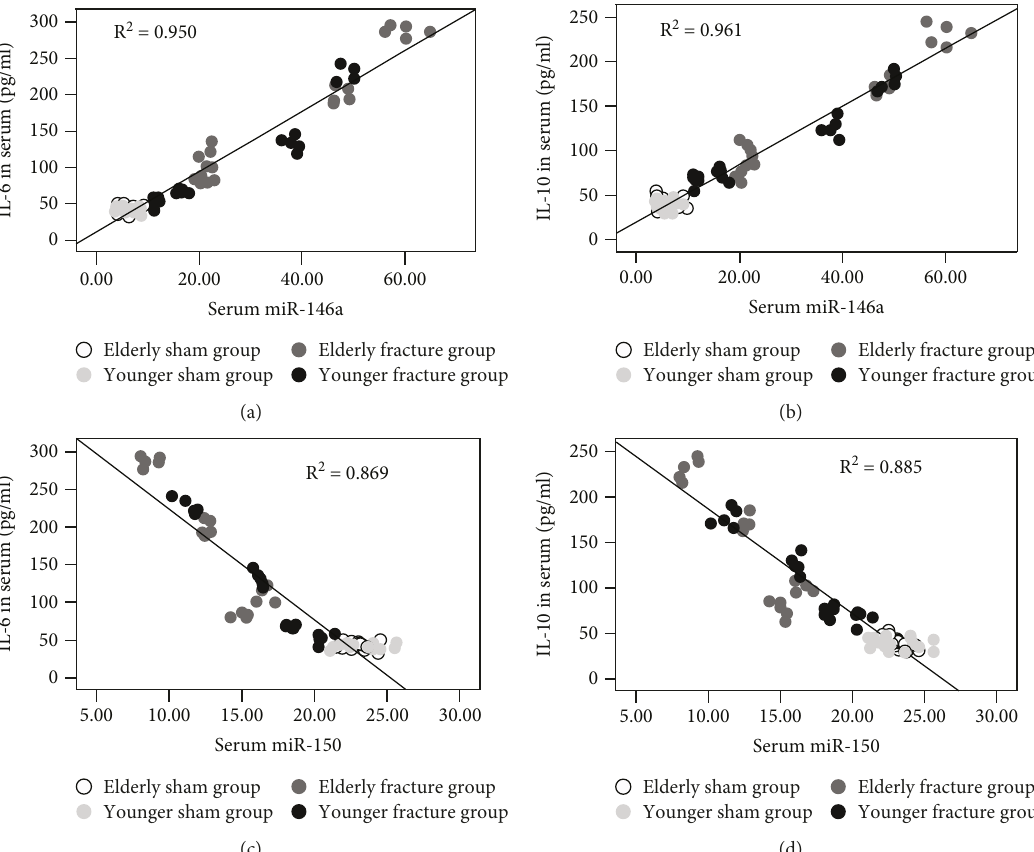
Figure 4: Scatter plots and regression lines showed that the serum miRNA-146a (a, b) and miRNA-150 (c, d) levels exhibited a signi fi cant relationship with the serum IL-6 and IL-10